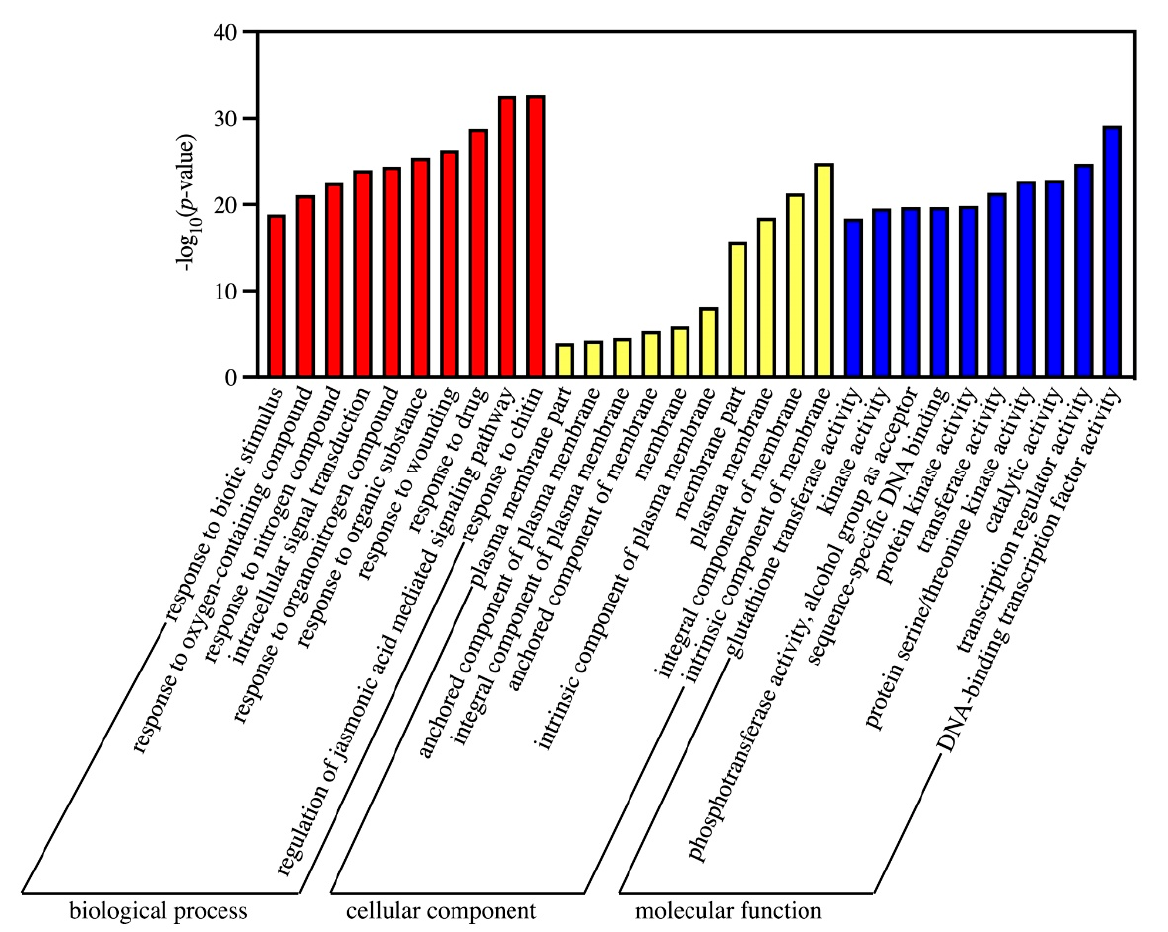
Figure 4. The top ten enrichment GO terms ( p < 0.05) analysis between 1Y and 1W. The x -axis is the name of GO terms; the y -axis represents the significantly enriched p -values with the logarithm of base 10.